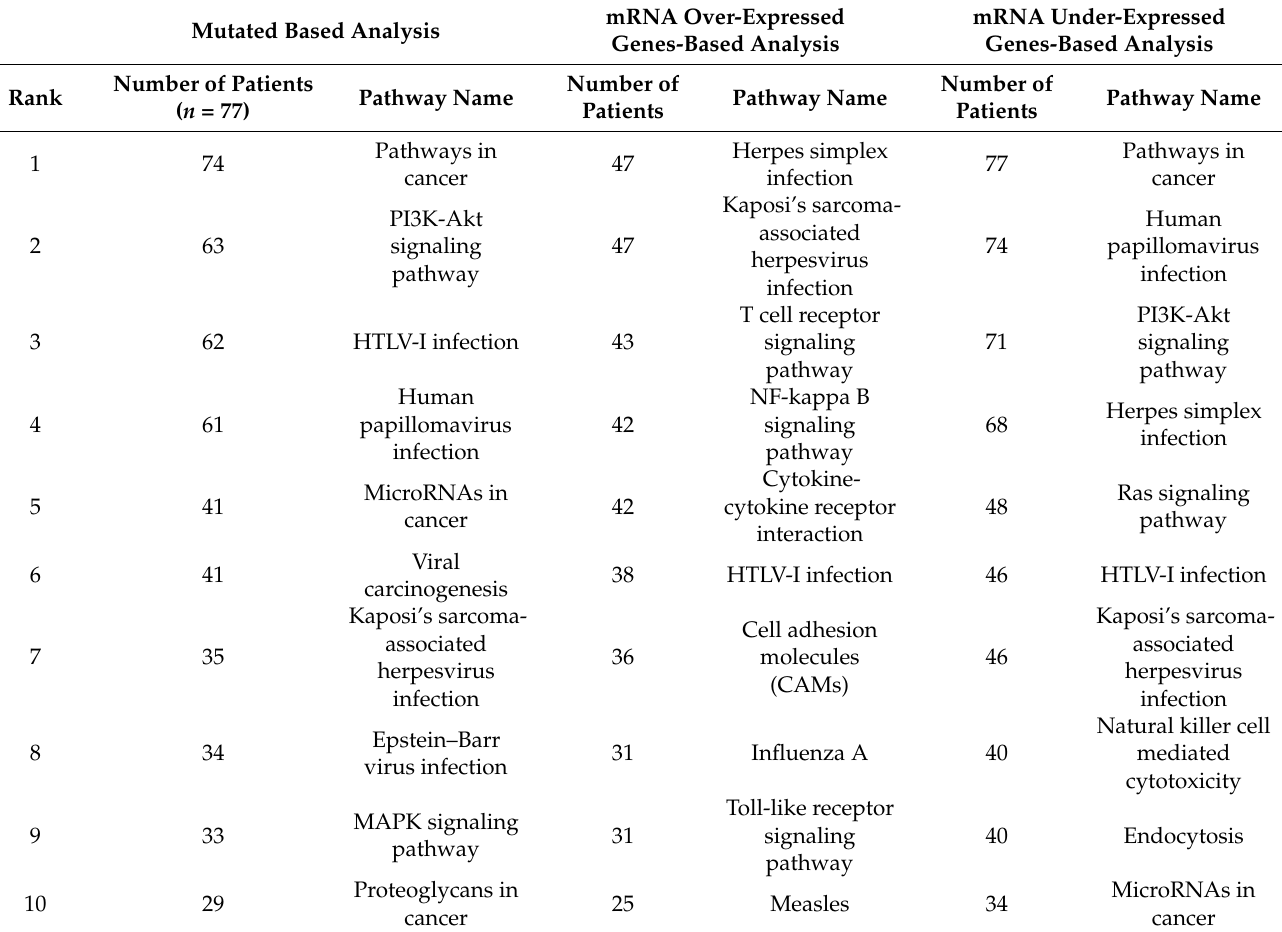
Table 2. Top 10 pathways discovered by mutation-based and mRNA over- or under-expressed genes-based analysis. Mutated Based